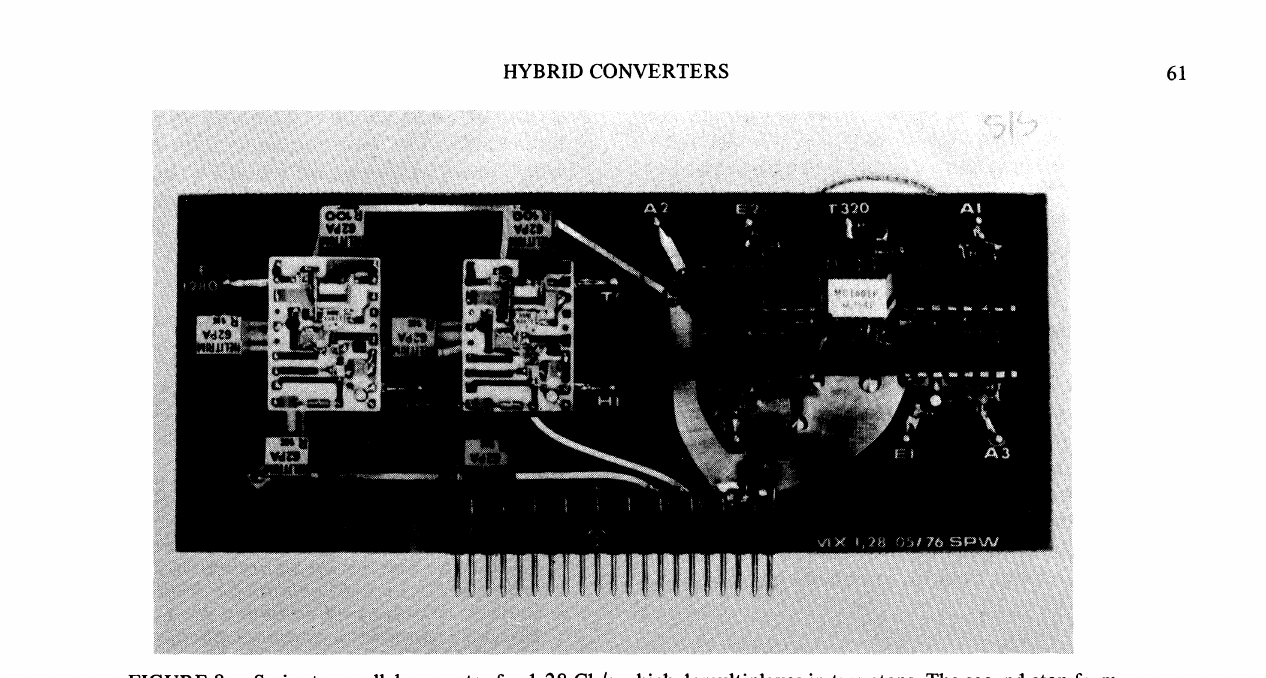
FIGURE 8 Series-to-parallel converter for 1.28 Gb/s which demultiplexes in two steps. The second step from 640 Mb[s to 320 Mb[s is done by monolithic flipflops.